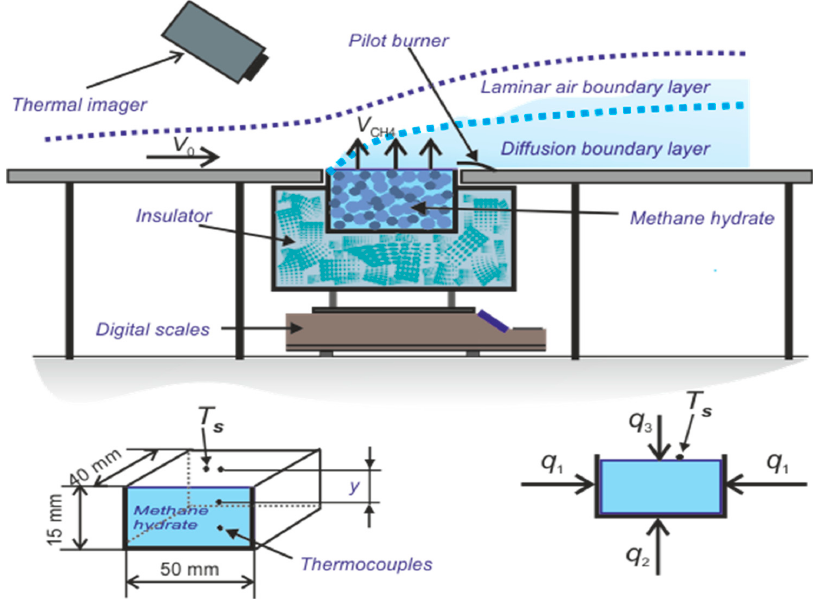
Figure 1. Scheme of experimental setup.